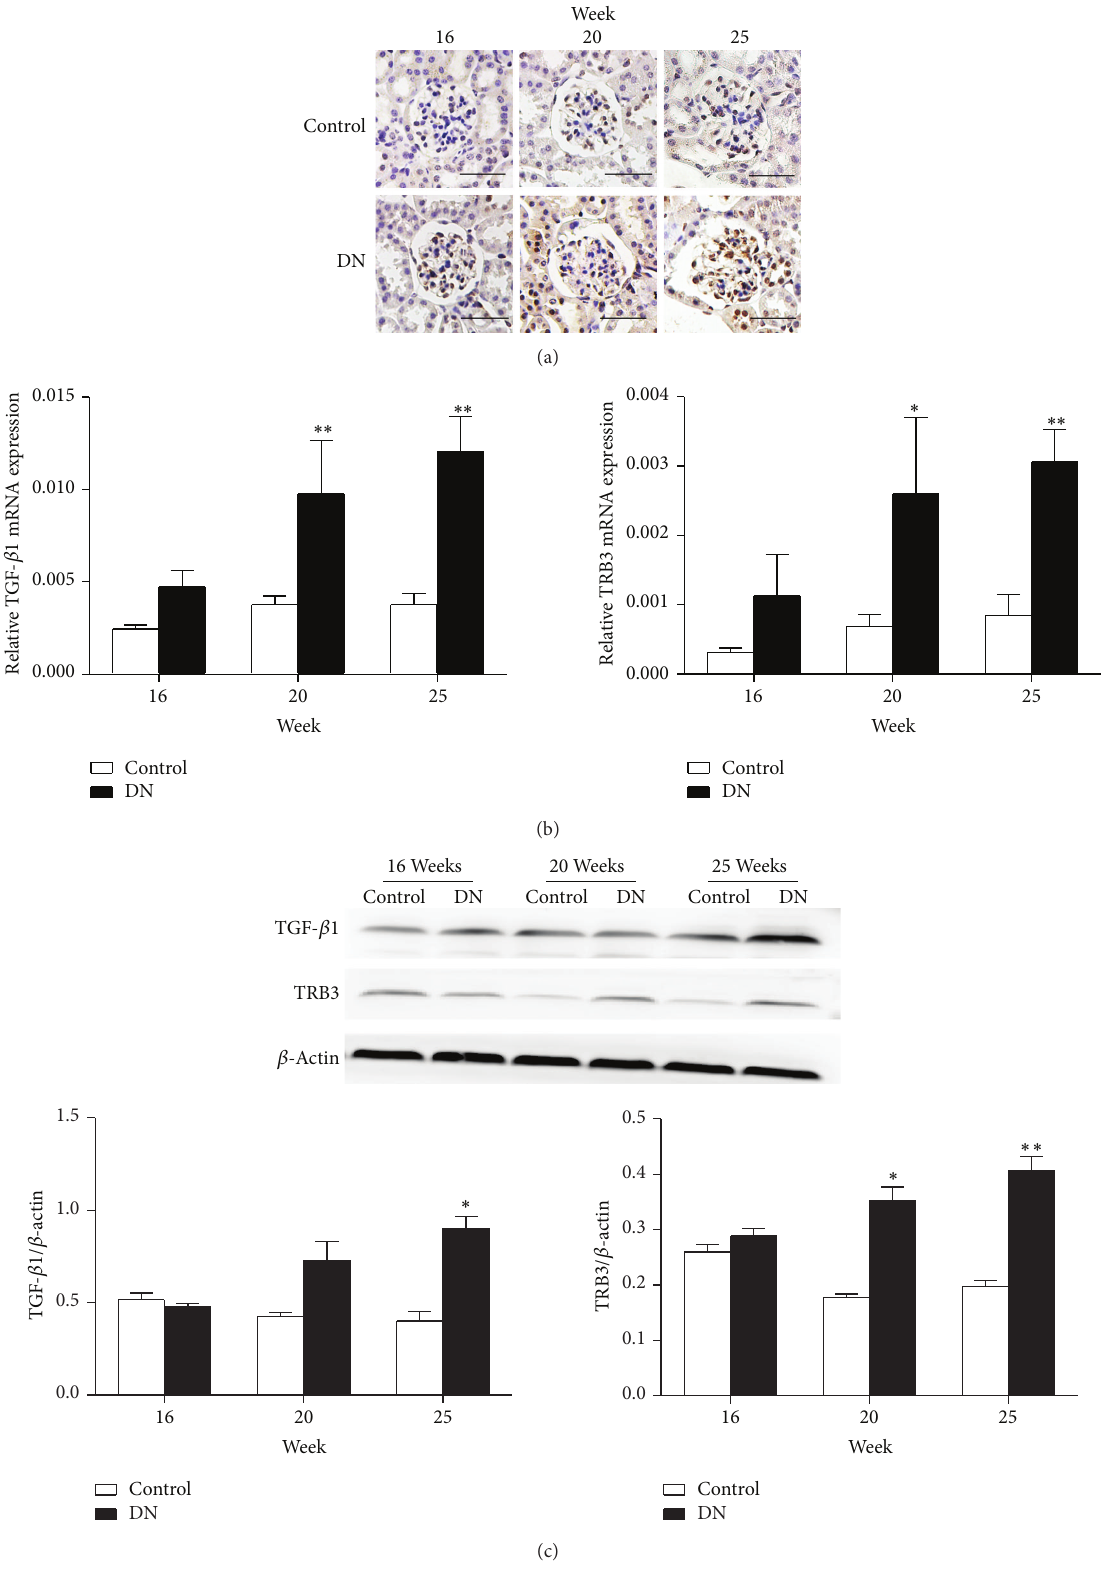
Figure 2: mRNA and protein expression of TGF- 𝛽 1 and TRB3 upregulated in DN mice. (a) Protein TRB3 level in nucleus of intrinsic glomerular cells and tubular epithelial cells. Total TGF- 𝛽 1 and TRB3 mRNA (b) and protein (c) levels by RT-PCR and western blot analysis, respectively. ∗ 𝑃 < 0.05 , ∗∗ 𝑃 < 0.01 versus age-matched control mice. Scale bars, 50 𝜇 m. 𝑛 = 5 mice per